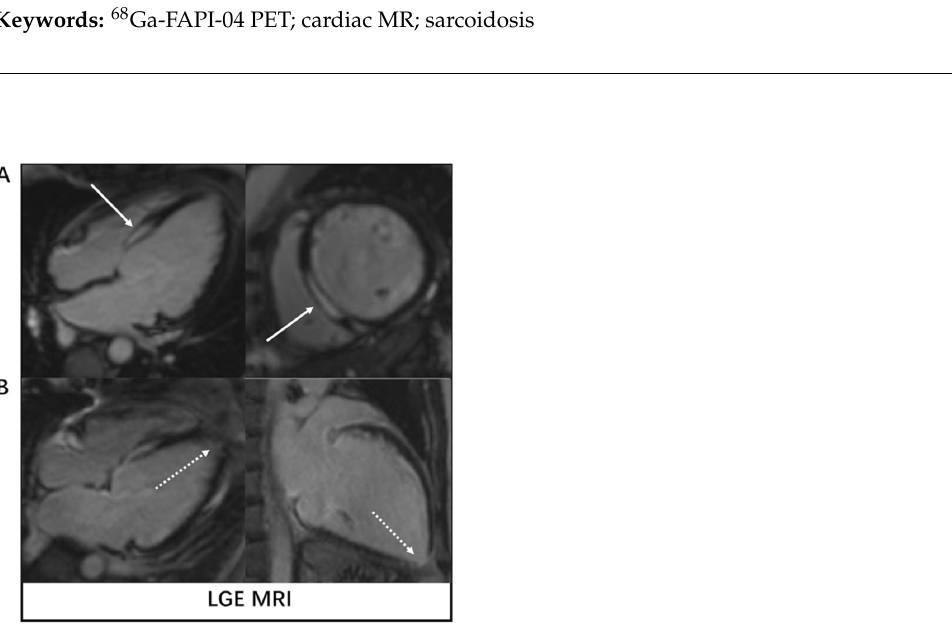
Figure 1. A 47-year-old female presented with intermittent fever, shortness of breath, and aggravated edema of the lower limbs over 4 months. Elevated N-terminal prohormone of brain natriuretic peptide (NT-proBNP) of 2450 pg/mL was recorded. The cardiac MR (CMR) images showed left ventricular (LV) enlargement (left ventricular end-diastolic diameter of 6.4 cm × 8.8 cm) with severe cardiac dysfunction (left ventricular ejection fraction, LVEF of 29.5%). Late gadolinium enhancement (LGE) in the septal (( A ), white solid arrows) and apex ( B ), white dashed arrows) of LV was revealed. Enlarged mediastinal and bilateral hilar lymph nodes were also noted. Lymphoma or other malignant diseases were suspected. Hence, whole-body 18 F-FDG and 68 Ga-FAPI-04 PET/CT were performed on two consecutive days for tumor